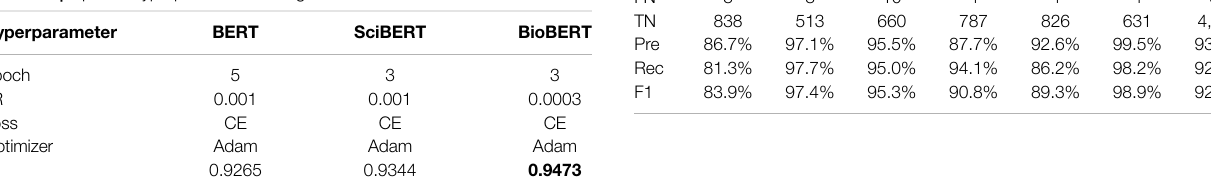
TABLE 5 | Optimal hyperparameter setting.